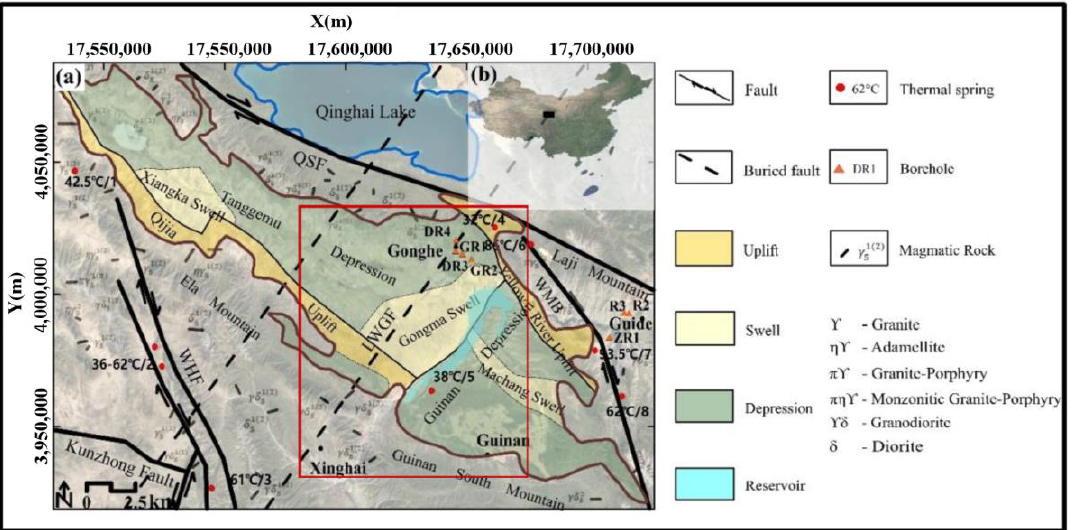
Figure 1. ( a ) Distribution of faults, wells and hot springs in the Gonghe Basin and surrounding areas, the red boxes represent the study and inversion region (revised from Wang et al., 2021 [6]); ( b ) location of the research area.